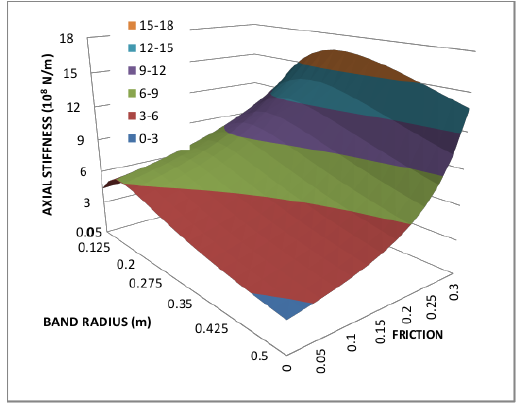
Figure 14: Axial stiffness for different v-band sizes with a range of coefficient of friction from 0 to 0.3 (theory).